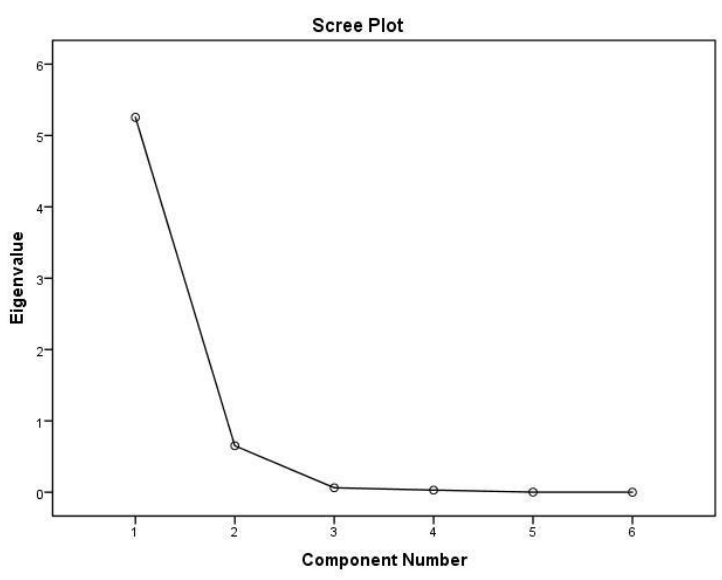
Figure 2. Scree plot indicating the number of factors to be extracted.